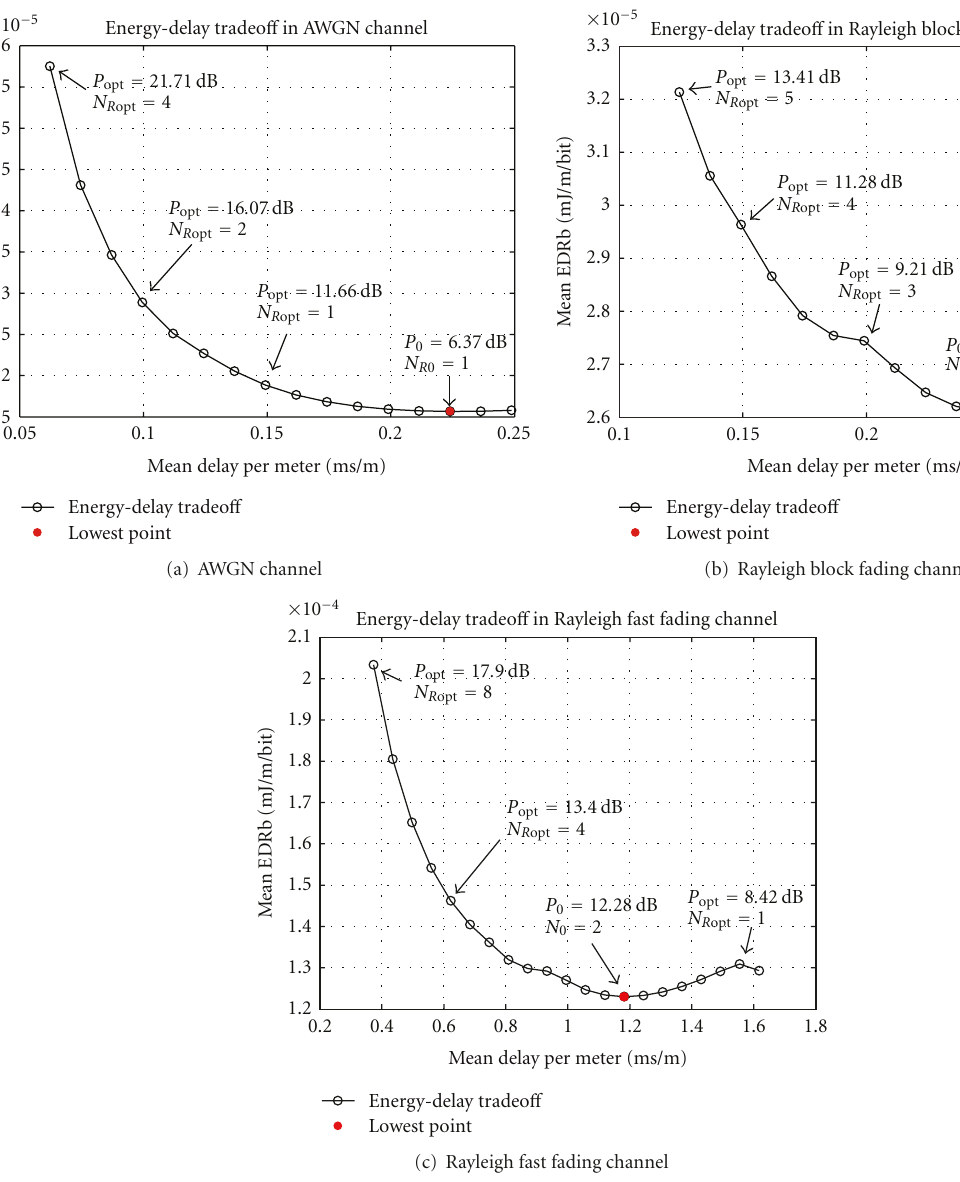
Figure 4: Lower bound of EDRb-DDR tradeo ff and corresponding parameters in di ff erent